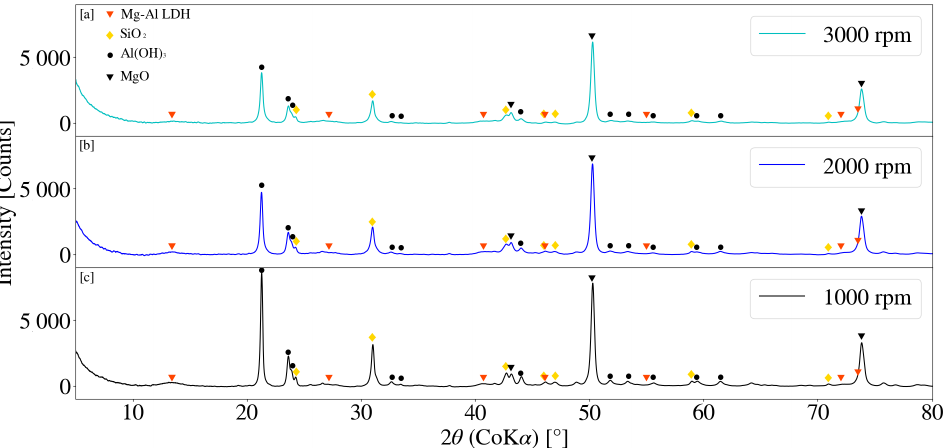
Figure 8. ( a ) X-ray diffraction pattern for Mg-Al LDH sample synthesised at a rotational speed of 3000 rpm (S3). ( b ) X-ray diffraction pattern for Mg-Al LDH sample synthesised at a rotational speed of 2000 rpm (S2). ( c ) X-ray diffraction pattern for Mg-Al LDH sample synthesised at a rotational speed of 1000 rpm (S1).Milling parameters were set at a retention time of 1 h, jacket water inlet temperature of 30 °C, media size of 2 mm and a solids loading of 10%.